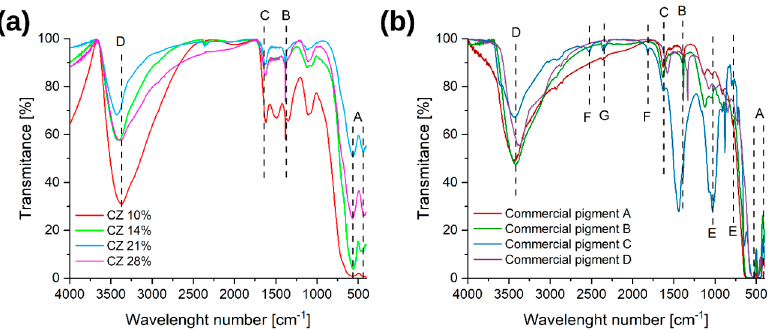
Figure 5. FTIR spectra for ( a ) laboratory pigments; ( b ) commercial pigments. A–G are the functional